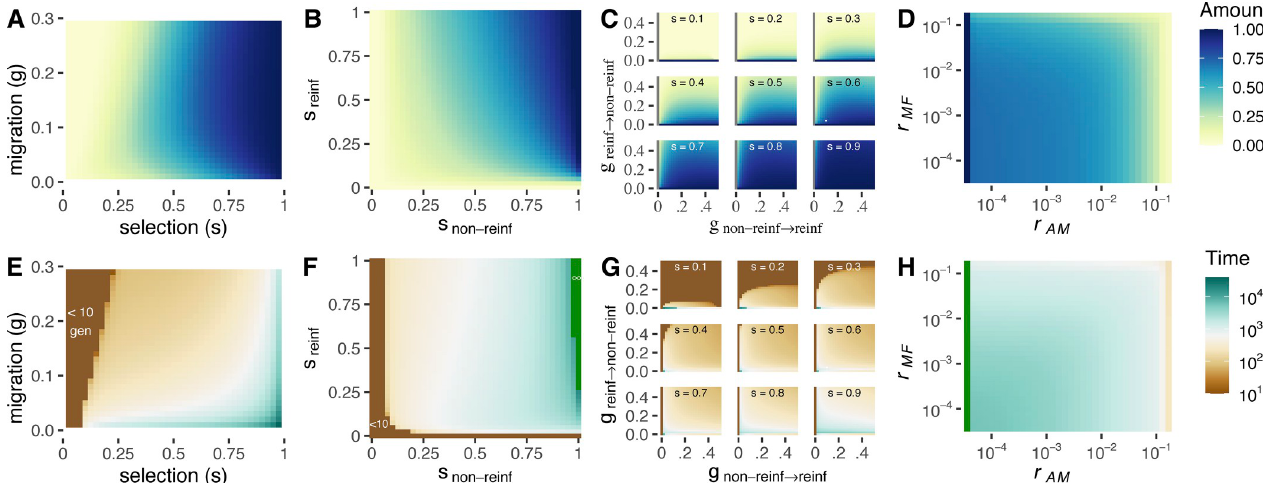
Fig 4. The maximum amount (A–D) and duration (E–H) of reinforcement. Reinforcement as a function of symmetric selection and migration ( A and E ) with r ¼ r = 10 − 4 , different selection coefficients in reinforcing and non-reinforcing populations’ environments ( B and F ), with g non-reinf ! reinf = AM MF g reinf ! non-reinf = 0.03 and with r AM ¼ r MF = 10 − 4 , asymmetric migration rates across numerous selection coefficients ( C and G , with r AM ¼ r MF = 10 − 4 ), and recombination rates ( D and H ) with a symmetric selection coefficient of 0.8 and g non-reinf ! reinf = g reinf ! non-reinf = 0.03. Complete or nontransient reinforcement is visible on the far right of figures F and H , indicated by the darkest green color, and the 1 symbol in F . The amount of reinforcement is quantified as ( p [ z , gen = x] − p [ z ,gen = 0] ) / p [ z ,gen = 0] , where p z equals the probability of being fertilized by nonmigrant sperm/pollen, scaled by the frequency of nonmigrant sperm/pollen. Time in generations is represented by “gen”. The data underlying this figure can be found in